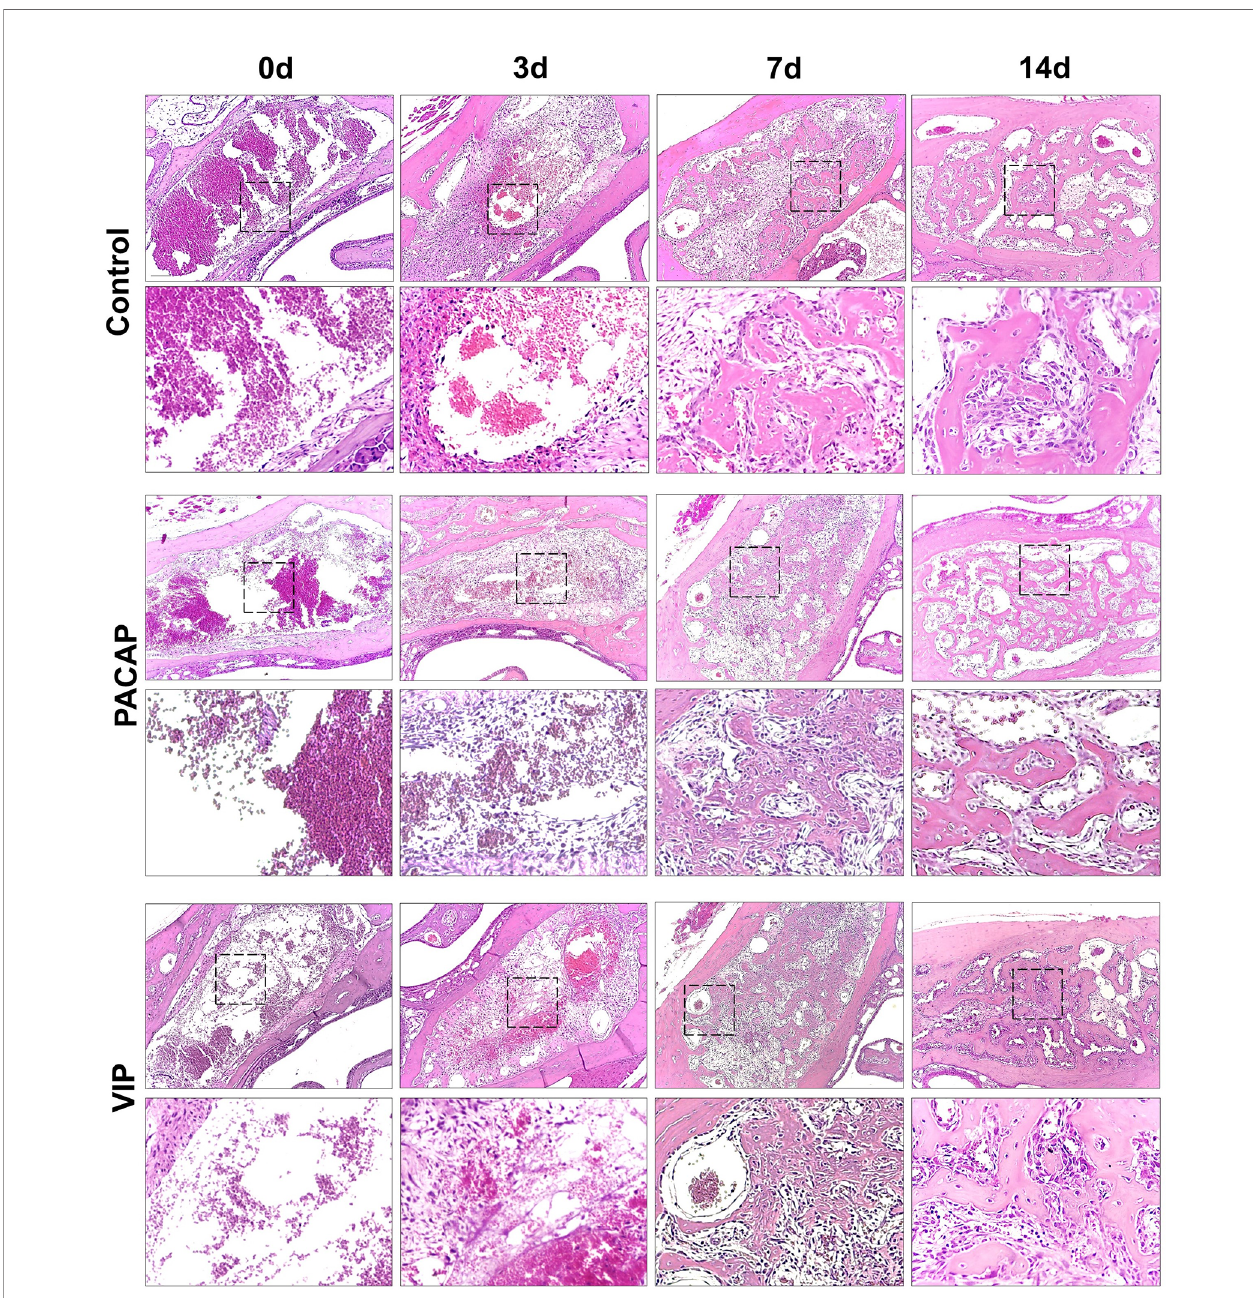
FIGURE 7 | Histological analysis of the alveolar healing process in control mice or treated with PACAP or VIP, in the 0h, 3-, 7-, and 14-day post-exodontia periods. Photomicrographs representing the average region of the dental alveolus in 10× magni fi cation; histological sections obtained after 0h, 3, 7 and 14 days after exodontia; HE